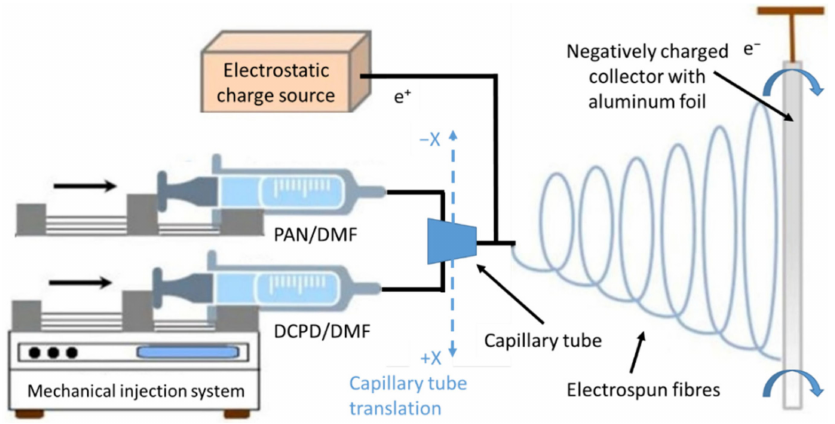
Figure 1. Schematic representation of the electrospinning process used to synthesise the self-healing microvascular network (adapted from [34]). Table 2. Microvascular network synthesis parameters.